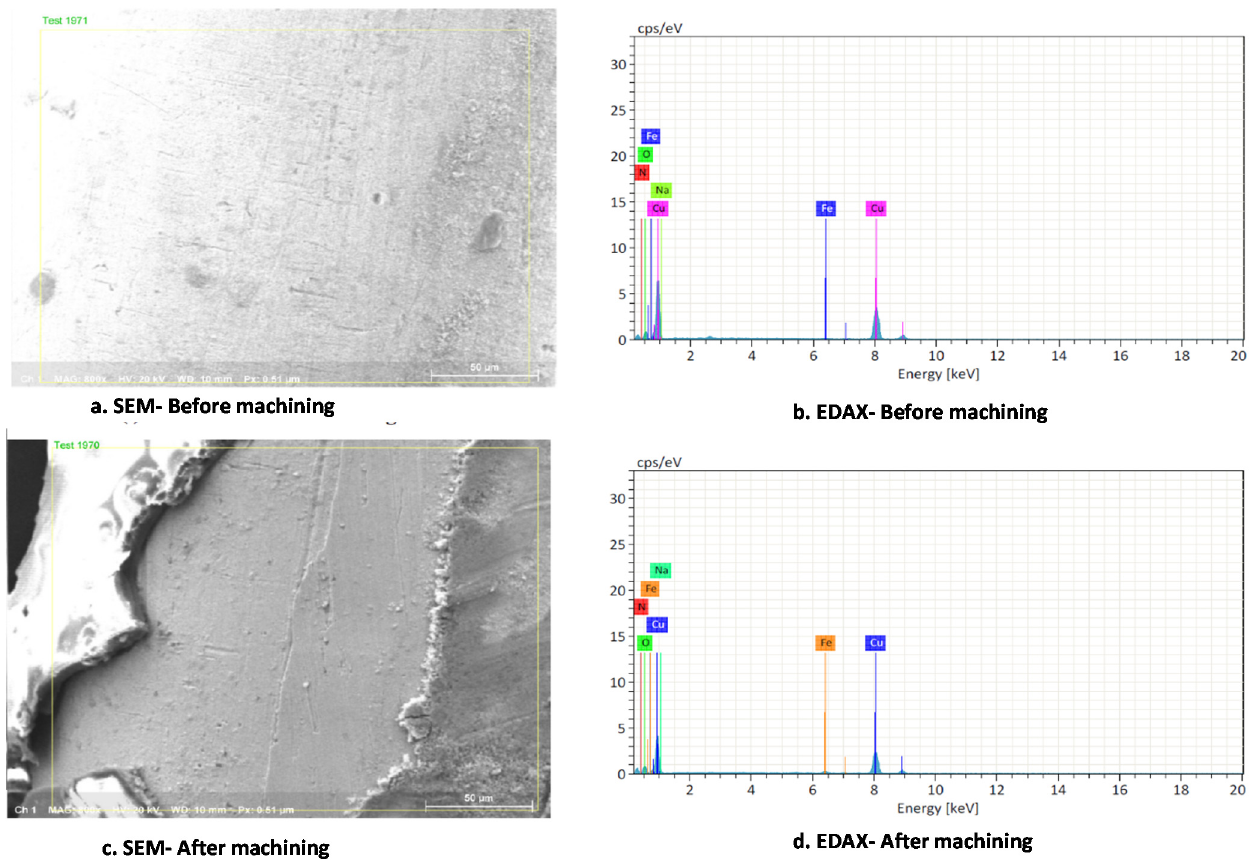
Figure 3. SEM and EDAX analysis of tool electrode before and after drilling process. ( a ) SEM-Before machining; ( b ) EDAX-Before machining; ( c ) SEM-After machining; ( d ) EDAX-After machining.